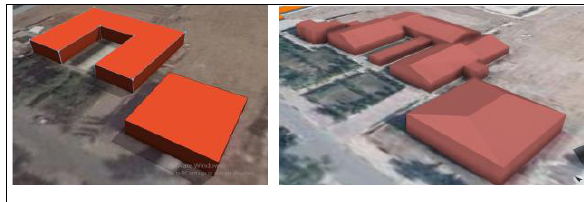
Figure 10. Two levels of details for the same buildings: (left) LoD1 from satellite imagery, (right) LoD2 from aerial imagery